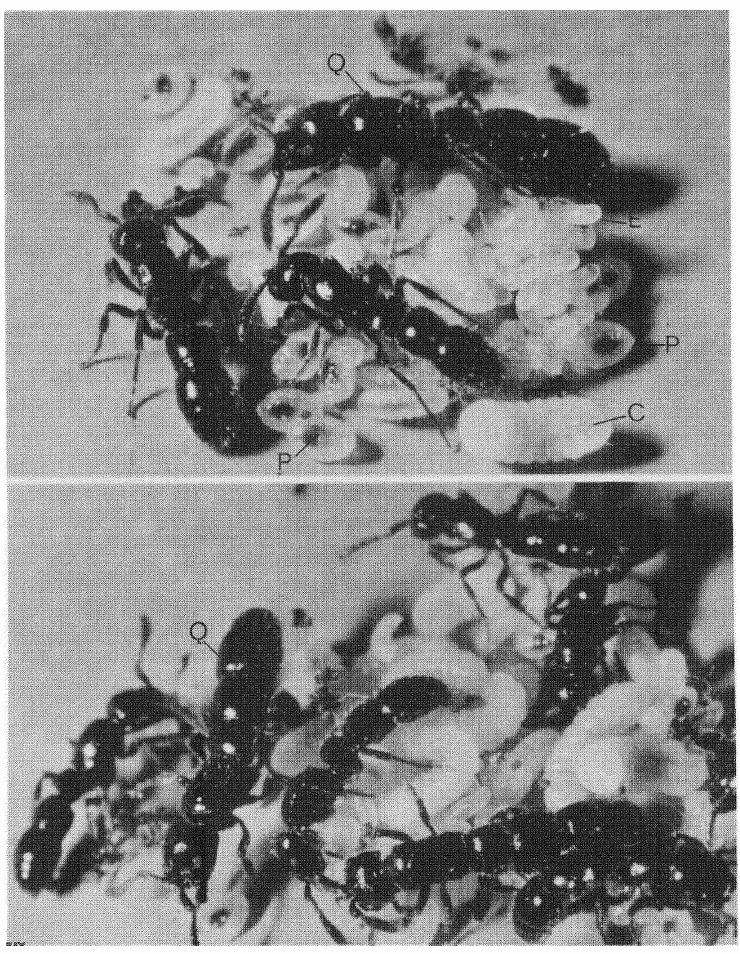
Figure 4. Fractions of a Cerapachys colony, with paralyzed prey larvae. Q: erga- toid queens; E: eggs; C: Cerapachys larvae; P: Pheidole prey